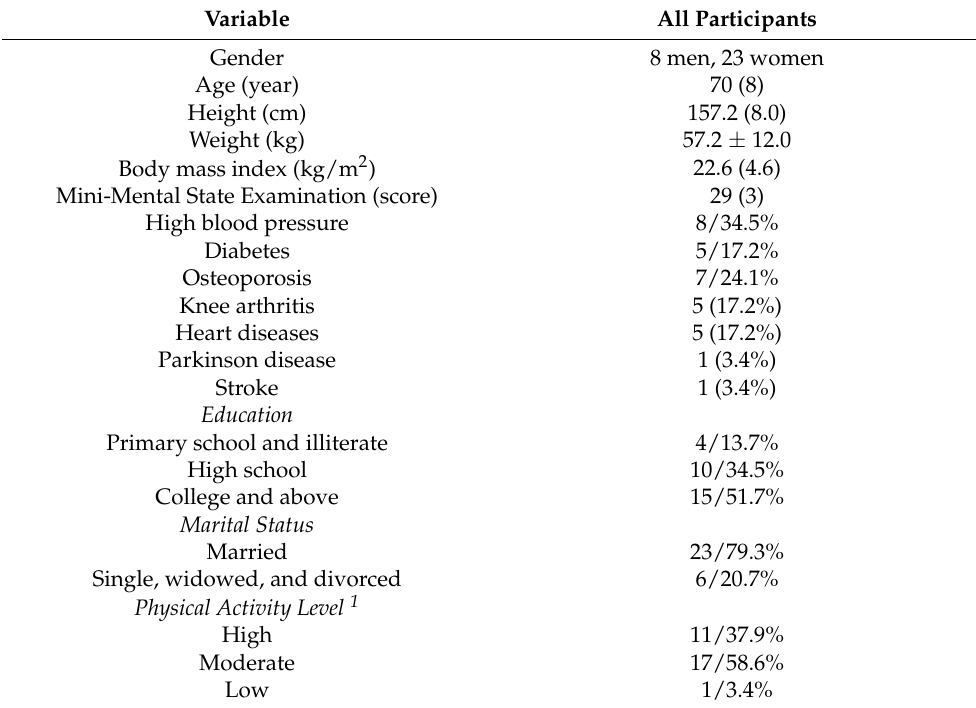
Table 1. Baseline characteristics of study participants ( n =